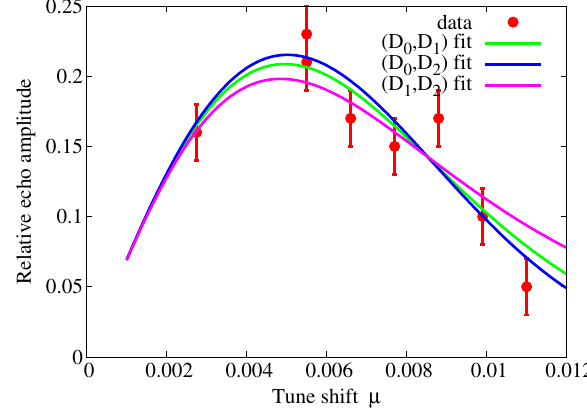
FIG. 3. Comparison of the echo amplitude vs the tune shift strength scan. The data are shown in red with error bars, while the fits shown are with the three models for the diffusion coefficients discussed in the text.